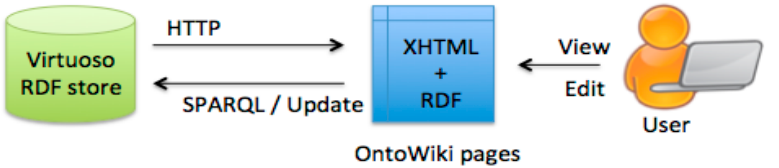
Figure 3. Climate Policy Database Setup.